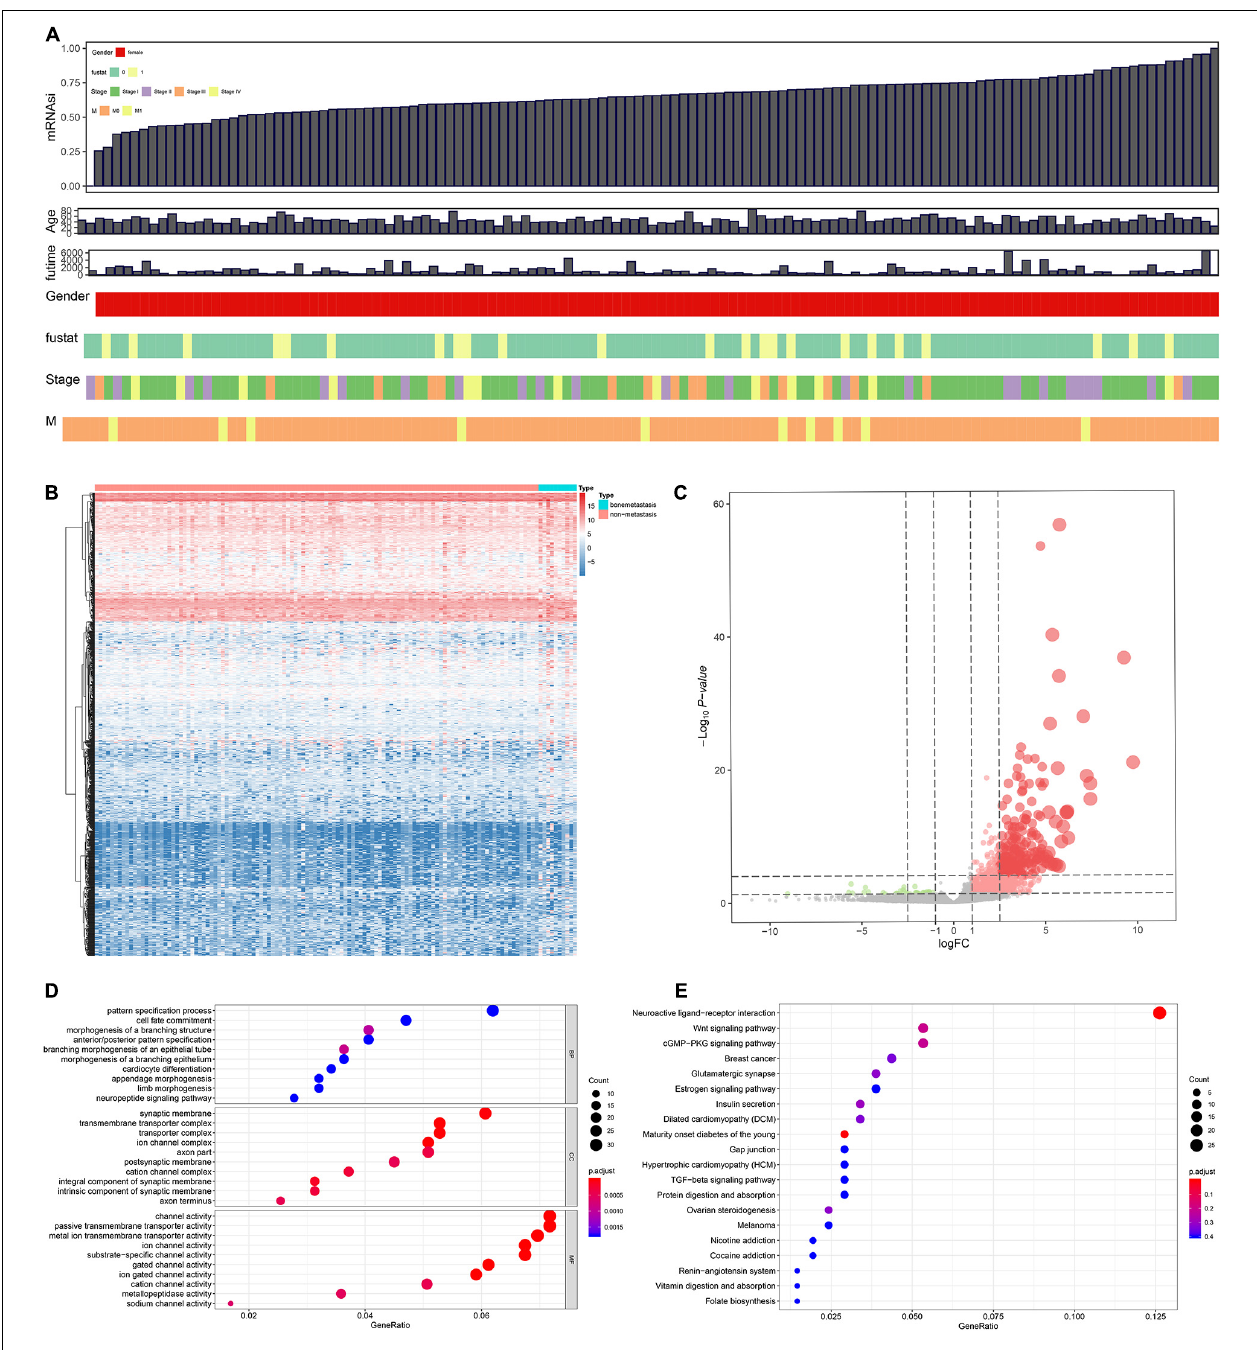
FIGURE 2 | Combinative analyses based on gene expression stemness indices (A) . Heat map for the differentially expressed genes (DEGs) between 10 metastatic and 116 non-metastatic patients with the cervical squamous cell carcinoma and endocervical adenocarcinoma (CESC) (B) . Volcano plot for DEGs between 10 metastatic and 116 non-metastatic patients with CESC (C) . The functional enrichment analysis for these DEGs in Gene Ontology (GO) terms (D) and Kyoto Encyclopedia of Genes and Genomes (KEGG) pathways (E) .